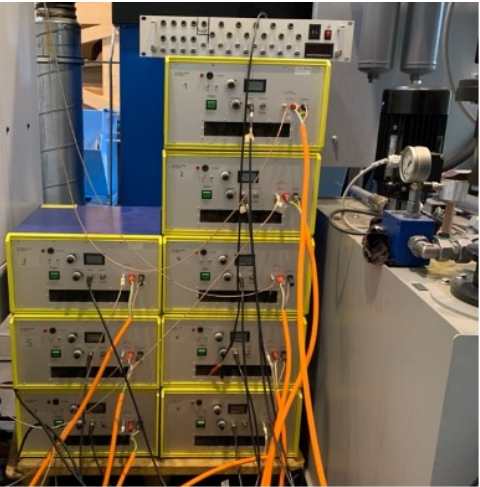
Figure 2. Signal amplifiers for piezoelectric actuators with stabilisation of different operating modes in the form of power capacitors (orange cables lead to the capacitor cascades packed in protective cases for safety at voltages above 1000 V).